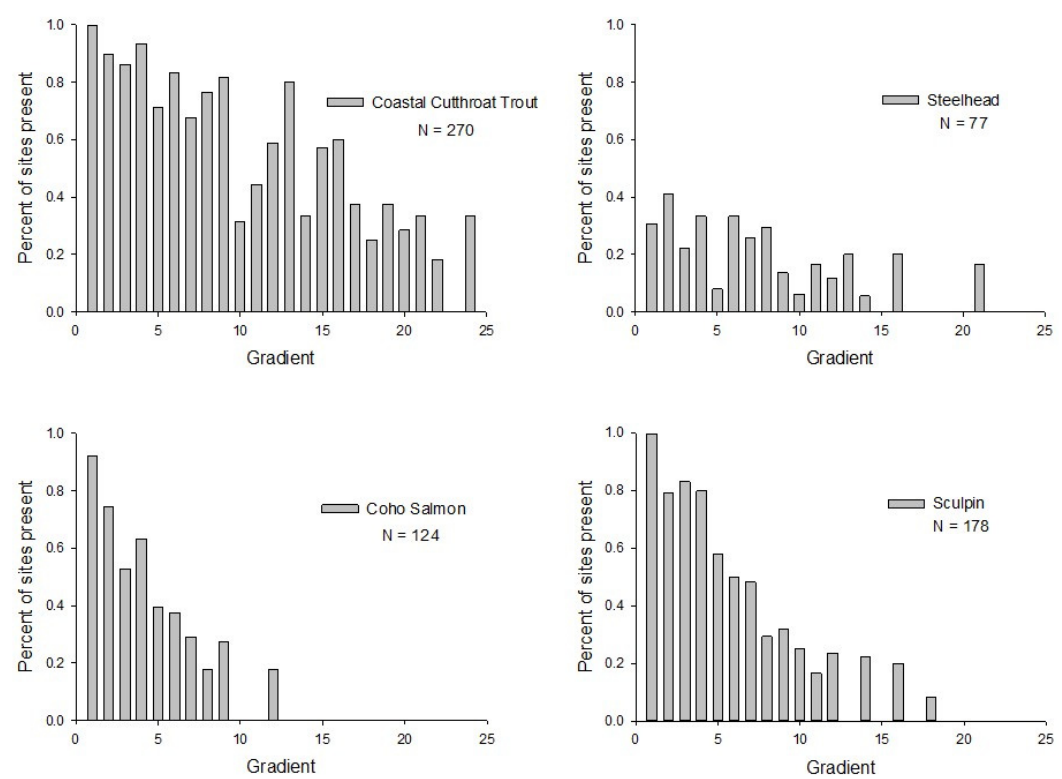
Figure 1. The percent of sites by stream gradient (%) that the most commonly found species (coastal cutthroat trout, coho salmon, steelhead, and sculpin) were encountered on the Olympic Experimental State Forest and Siuslaw National Forest.